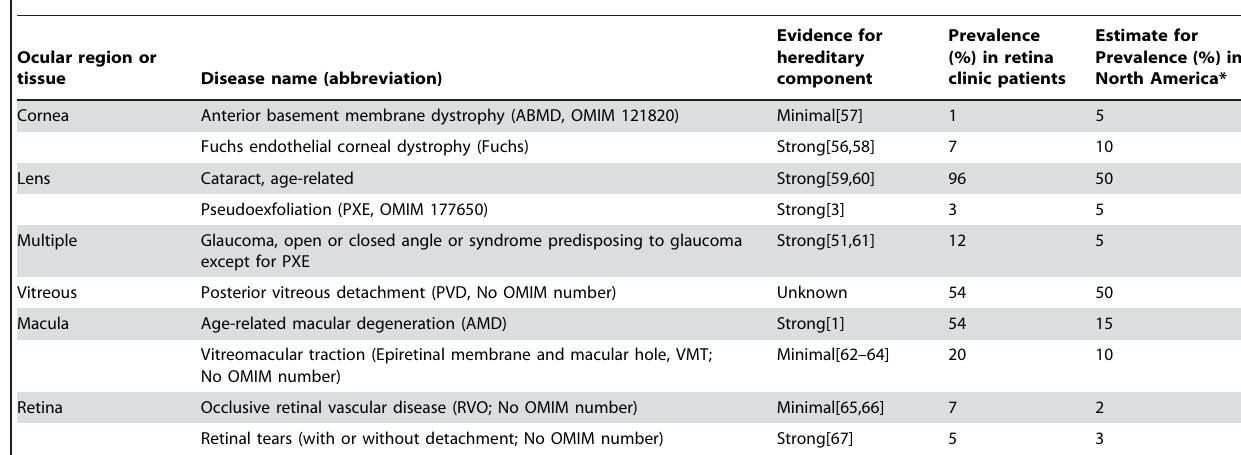
Table 1. Common complex traits documented in 100 consecutive